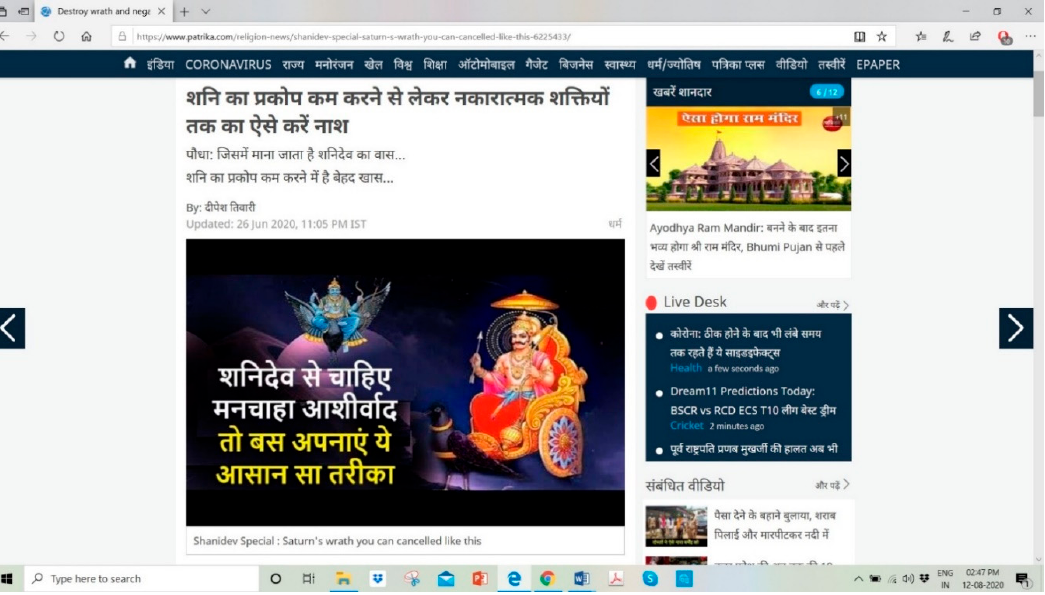
Figure 4. Shani riding a golden chariot. Source: AmarUjala.